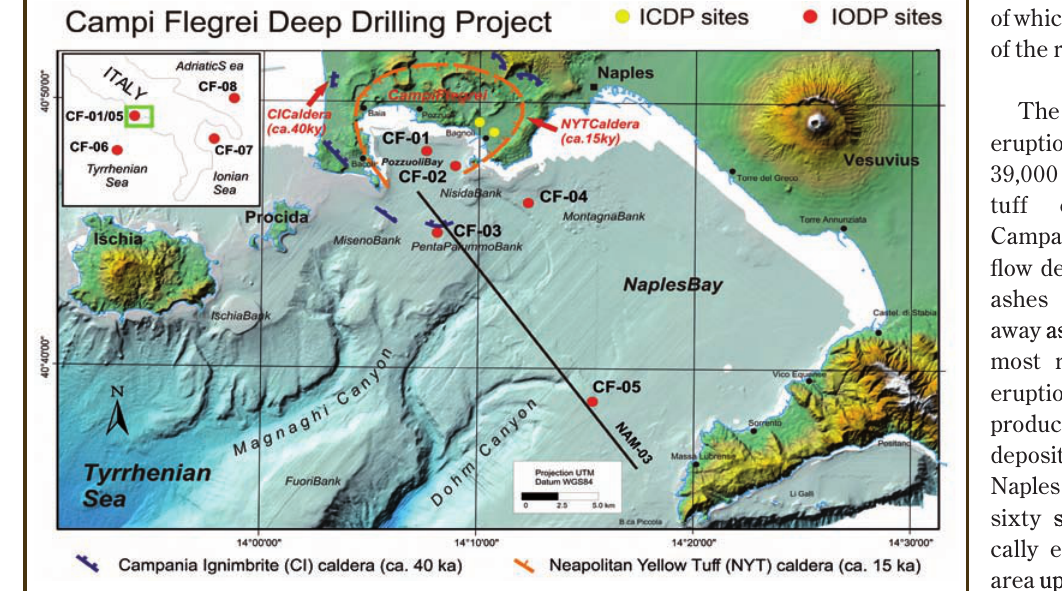
Figure 1. Planned drilling locations on land (yellow circles) and offshore (red circles). The rationale for the choice of offshore locations is described as follows: [CF-01] caldera center, in order to penetrate the struc- tural floor of the NYT caldera (1.5–2 km) and sample the tectono-stratigraphic interval likely involved in the late stage caldera resurgence; [CF-02] (optional, or alternate) along-transect site within the NYT caldera collapse, in order to drill the caldera fill at site of minor stratigraphic thickness (~0.8–1.0 km); [CF-03] targets the external rim of the caldera and penetrates a relatively complete stratigraphic section (~0.6–0.8 km deep); [CF-04] is located just outside the hypothetical caldera collapse, in order to sample the non-collapsed strati- graphic sequence (0.8–1.0 km); [CF-05] intended to sample a Quaternary tephro-stratigraphic reference section (1 km) in a relatively undisturbed location; [CF-06–08] relatively shallow drillholes (0.4–0.6 km) are planned at distal site locations to capture major explosive events of the entire Campania volcanic district and map the regional dispersal areas to aid reconstruction of the dynamics and evolution of eruptive